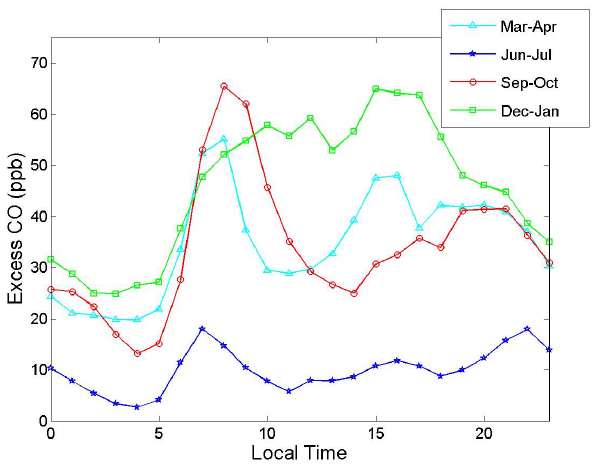
Fig. 6. Diurnal variation of excess carbon monoxide mixing ratios at Kumpula site in Helsinki during the four seasons in 2007–2008. The record is a combination of workday and weekend